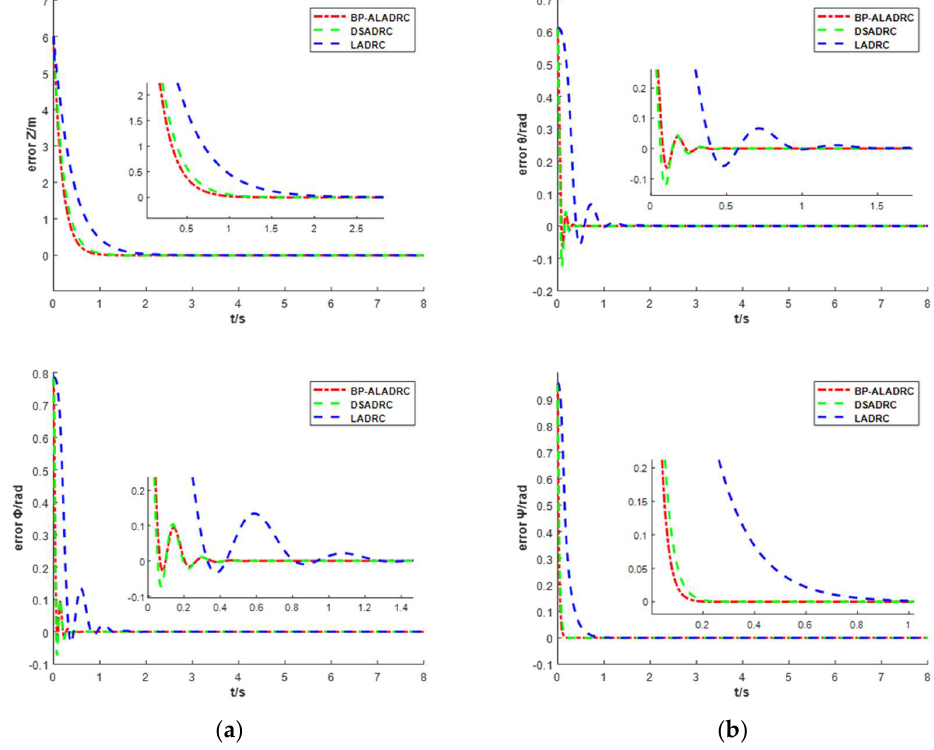
Figure 5. System output errors: ( a ) Altitude and Roll angle output errors; ( b ) Pitch and Yaw angle output